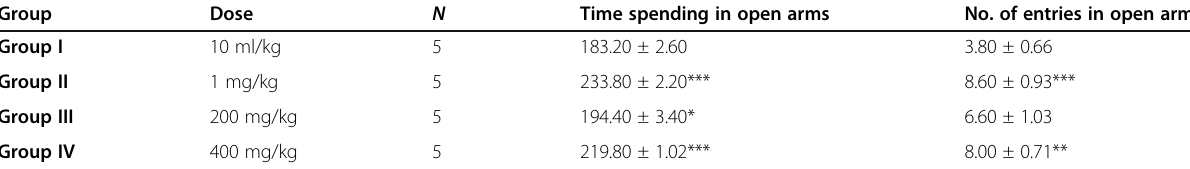
Table 2 Effect of leaves extract on time spent and the number of entries into open arms in elevated plus maze test Group